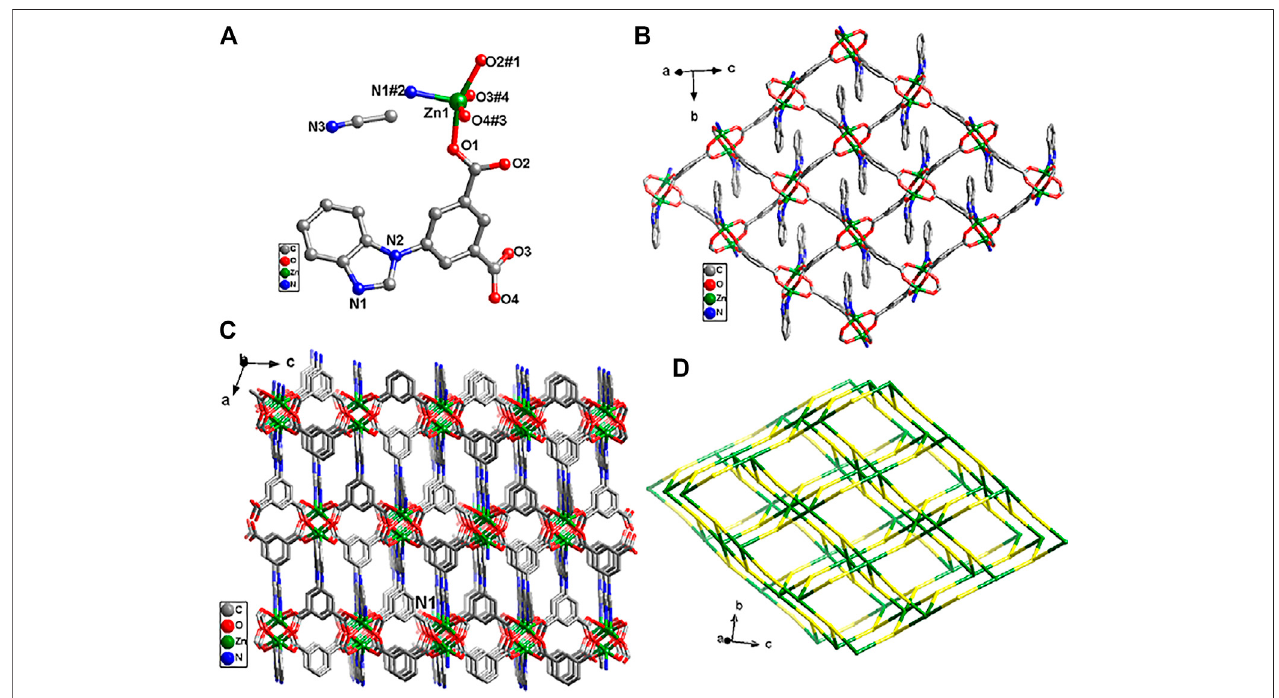
FIGURE 1 | (A) Coordination environment of Zn 2+ ion. (B) The 2D layered structure of Zn-MOF. (C) View of the three-dimensional structure of Zn-MOF. (D) Topological analysis of Zn-MOF. Symmetry codes: #1 − x+1, − y+1, − z; #2 − x+2, y+1/2, − z+1/2; #3 x, − y+1/2, z − 1/2; #4 − x+1, y+1/2, − z+1/2.